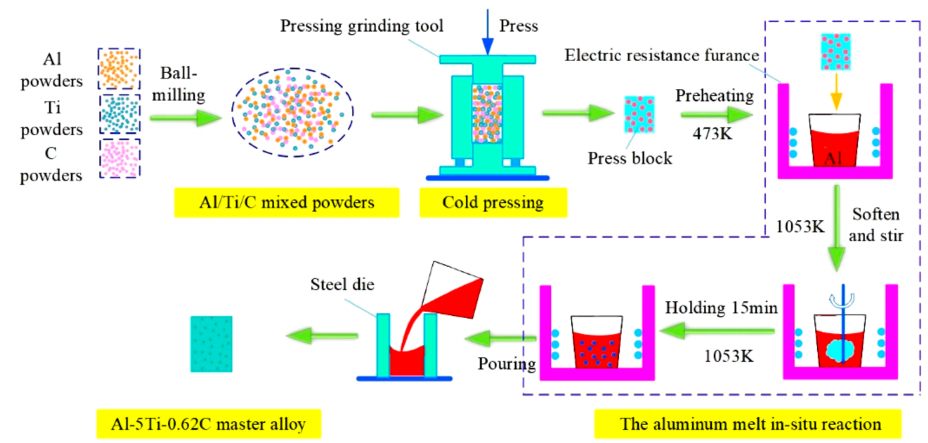
Figure 1. The experimental flow chart of the preparation of the Al-5Ti-0.62C master